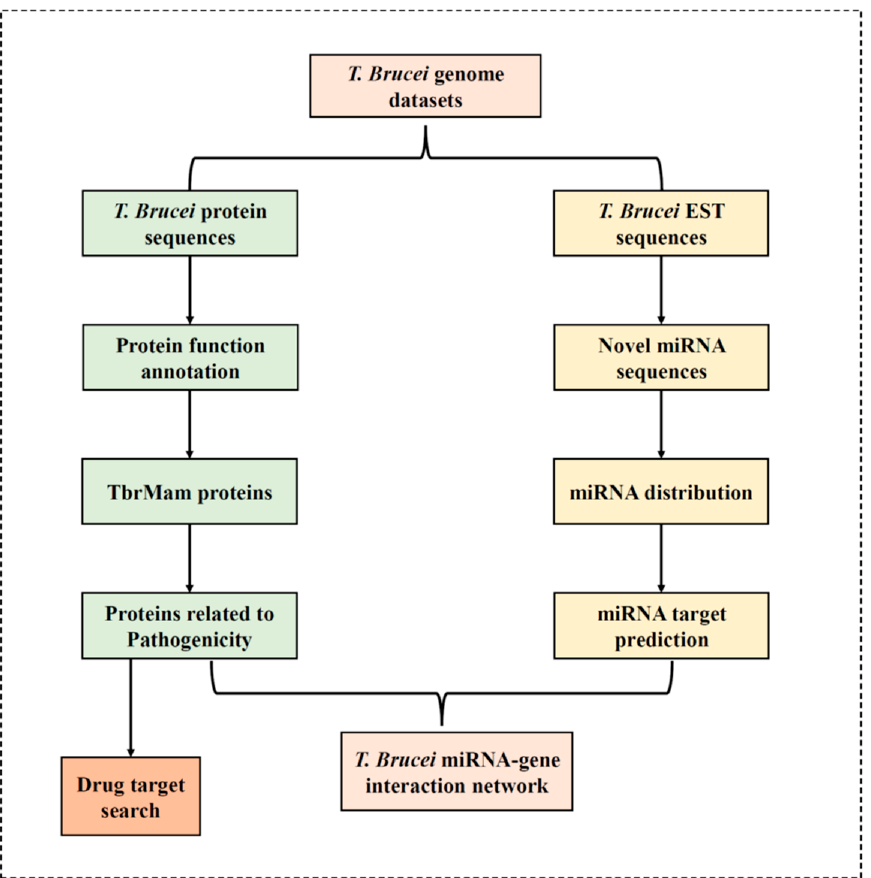
Figure 1. Workflow in this study. Our work was divided into two main parts: protein-coding gene analysis and miRNA analysis.